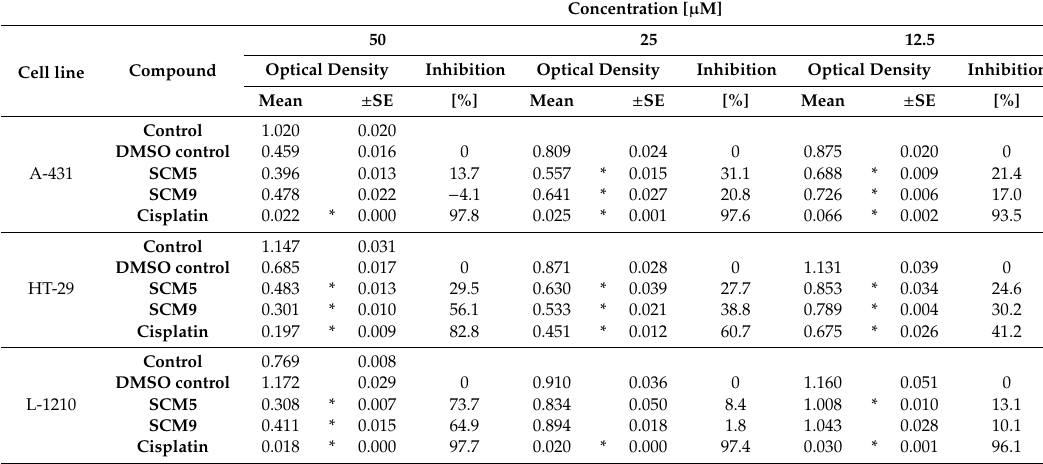
Table 3. E ff ect of SCM compounds on growth of tumor lines. The compounds were added to the cultures at concentrations of 50, 25 and 12.5 µ M. The cell lines were incubated for 3 days and cell viability was determined using a MTT colorimetric method. The data are presented as optical density (OD) values from quadruplicate wells ± SE. Control cell cultures contained cisplatin (dissolved in medium only).